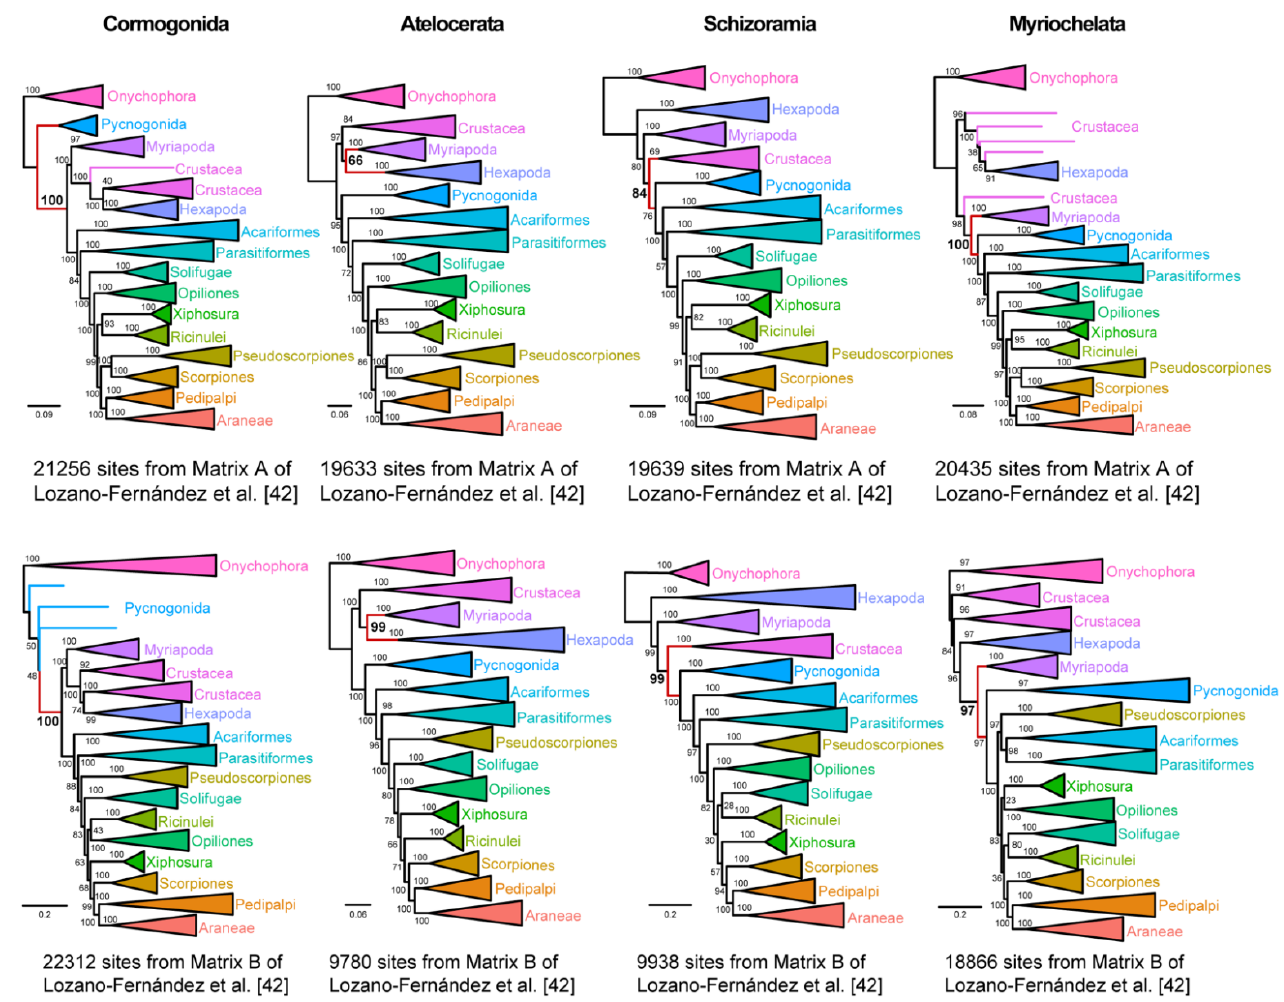
Figure 3. Cherry-picking molecular data to recover preconceived, traditional relationships can be used to justify debunked groupings. Top row: Topologies derived from Matrix A of Lozano-Fern á ndez et al. [42]. Bottom row: Topologies derived from Matrix B of Lozano-Fern á ndez et al.